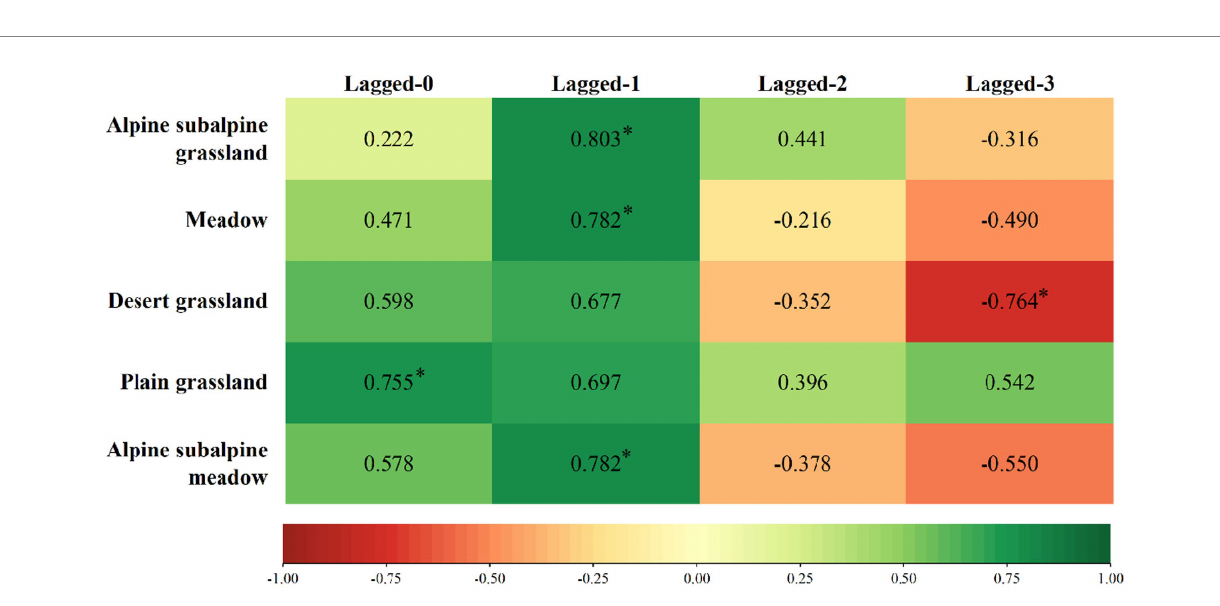
FIGURE 10 Correlation of the time lag effect of NPP on SPEI for different grassland types in Xinjiang from 1982 to 2020. (* indicates a significance level of 0.05, whereas ** indicates a significance level of